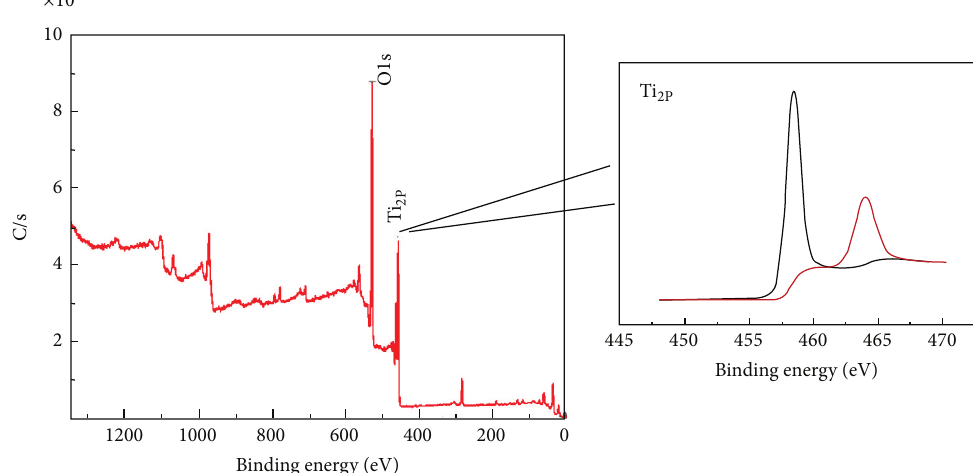
Figure 8: XPS spectrum of all elements of rutile TiO 2 and XPS spectrum of